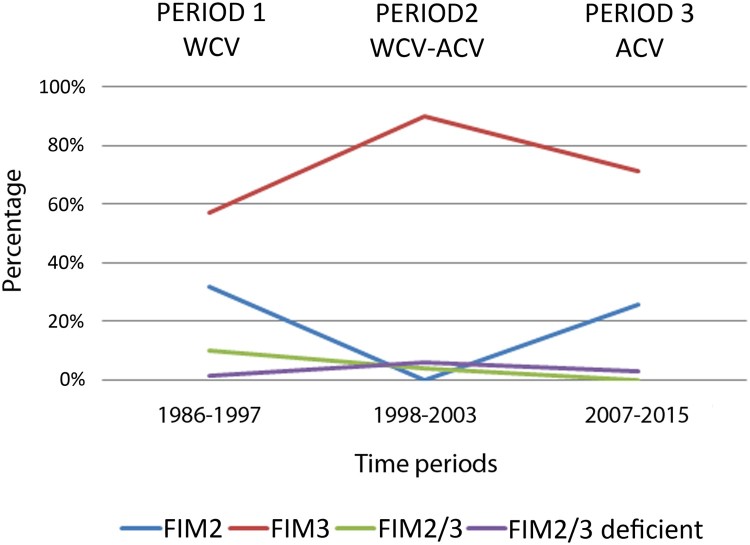
Evolution of fimbrial serotypes in B. pertussis isolates circulating in the metropolitan area of Barcelona from 1986 to 2015. WCV: Whole cell vaccine; ACV: Acellular vaccine.